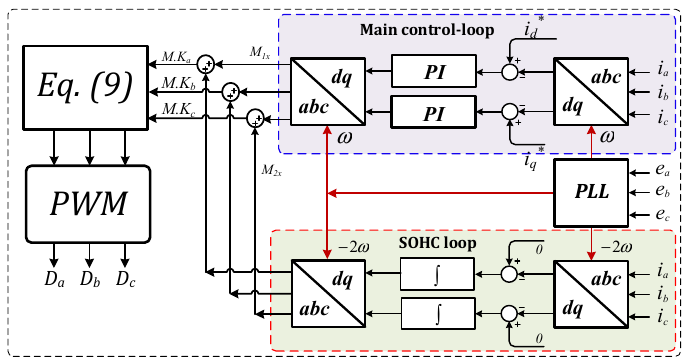
Figure 4. Closed-loop control scheme of the proposed IFBI.